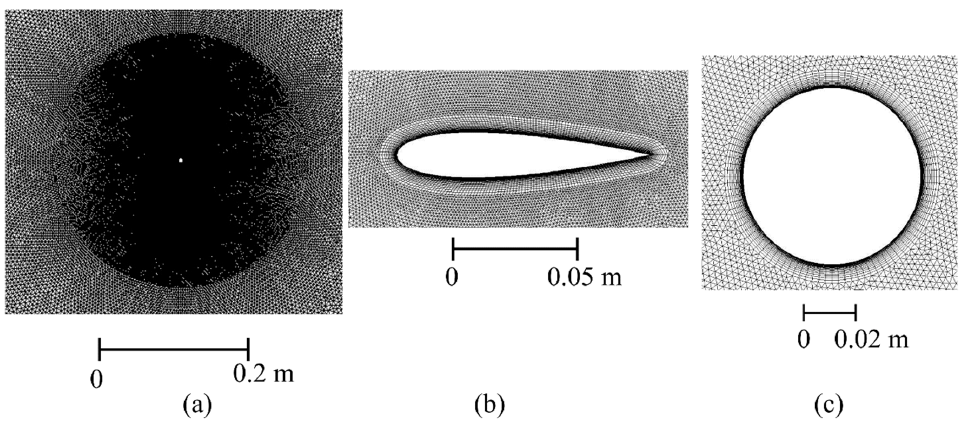
Figure 4. Grid distribution. ( a ) Mesh density in the rotor area; ( b ) Mesh around the blade; ( c ) Grid near the rotating shaft.